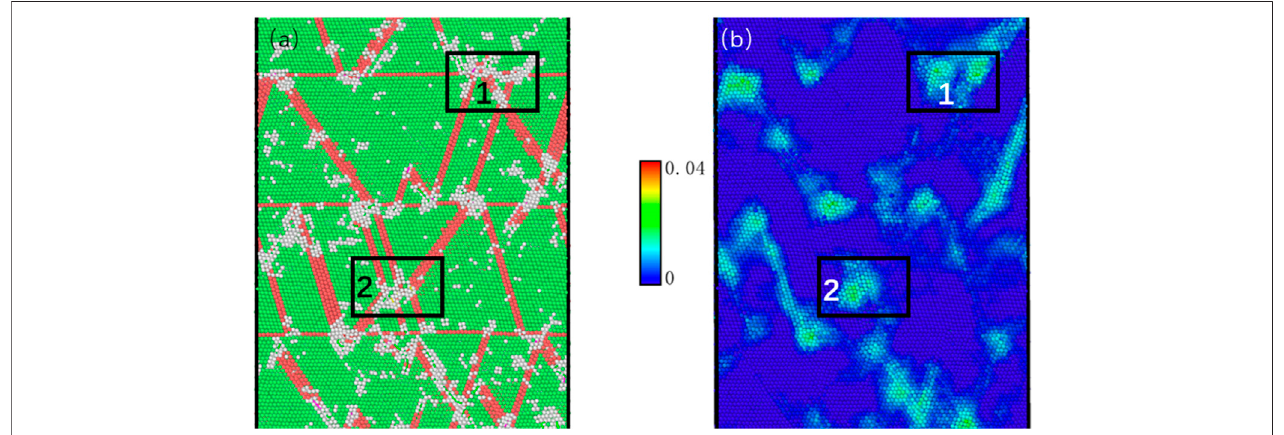
FIGURE 10 | The microstructure of nt-HEAs ( λ = 3.08 nm) under different strains (A) 2.6%, (B) 3%, (C) 10%, (D) 15%.